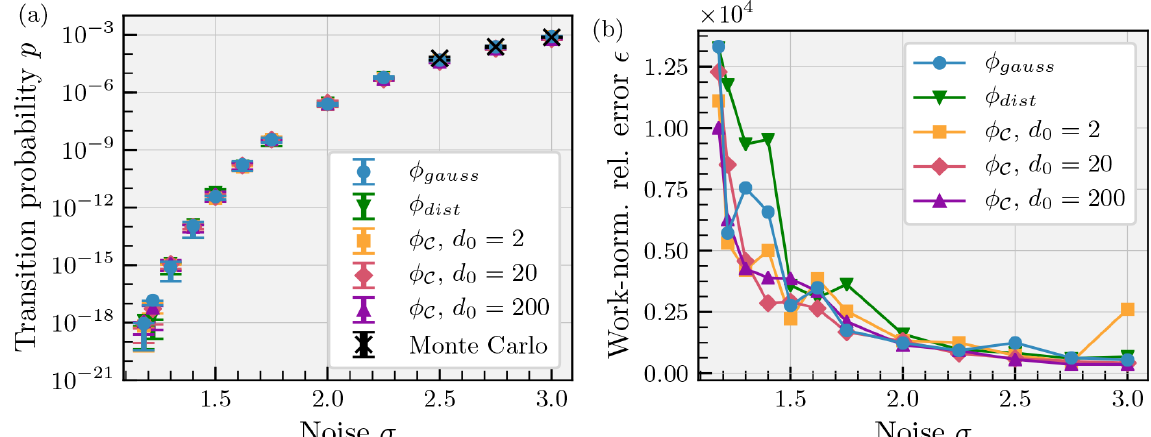
Figure 8. (a) Transition probability p as a function of noise parameter σ . Mean estimates and interquartile range (error bars) over N samples = 10 independent realisations of the TAMS algorithm using the score functions φ dist (green down triangle), φ gauss (with β = 1 . 5, blue circle) and φ C with decay parameters d 0 = 2 , 20 , 200 (yellow square, pink diamond, purple up triangle) are shown. The Monte Carlo estimate (black cross) has been run with N = 5 × 10 5 trajectories with the target sets coinciding with the confidence ellipsoids around X B , with associated √ p( 1 − p)/N (error bars). There is an overall good agreement between the numerical estimations. The path-based standard deviation σ p = score function is robust to the choice of decay parameter. (b) Performance of the score functions measured by the work-normalised error (cid:15) as a function of noise σ (same markers as panel a ). At most, there is a 30% decrease in error when using the path-based score function φ C at low noise. Note that at high noise σ = 3, using a short decay length d 0 = 2 with φ C leads to poor performance because the greater values of φ C are tightly concentrated around the estimated instanton, whereas typical transition paths are not necessarily clustered around it. Otherwise, the performances of the score functions are roughly